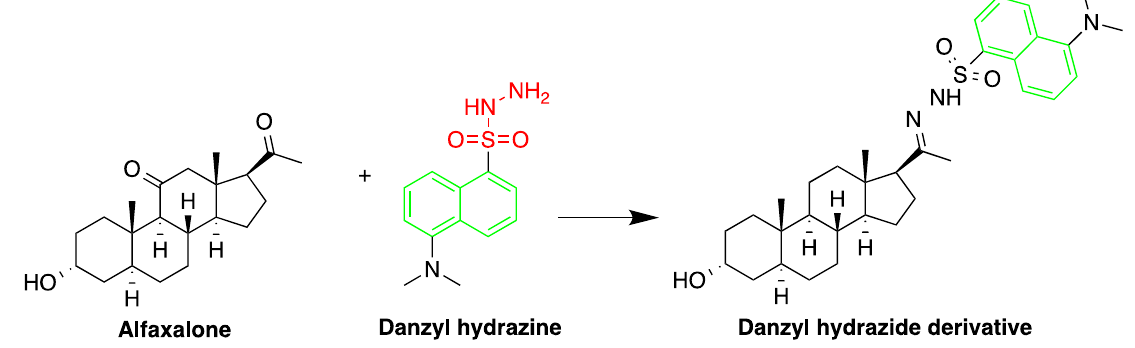
Figure 16. Derivatization of alfaxalone by dansyl hydrazine.